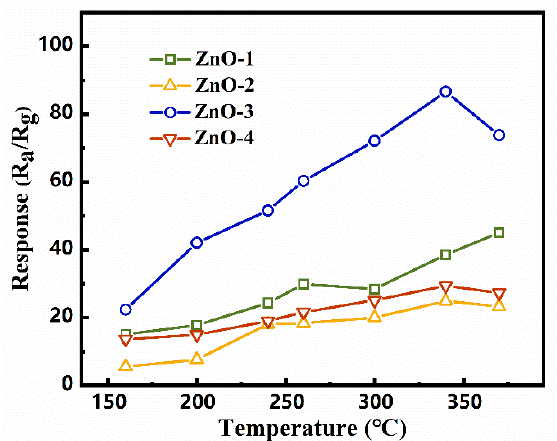
Figure 5. Responses of sensors exposed to 100 ppm n -butanol at different operating temperatures. Crystals 2020 , 10 , x FOR PEER REVIEW